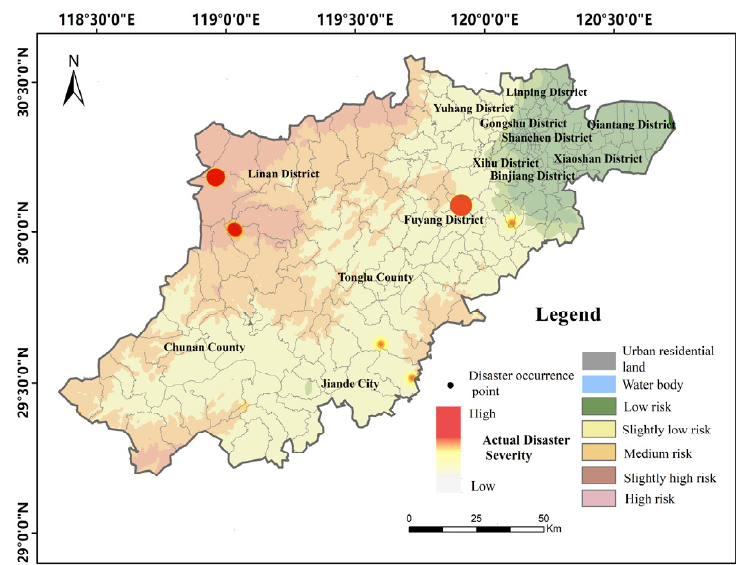
Figure 9. Frozen injury of tea.